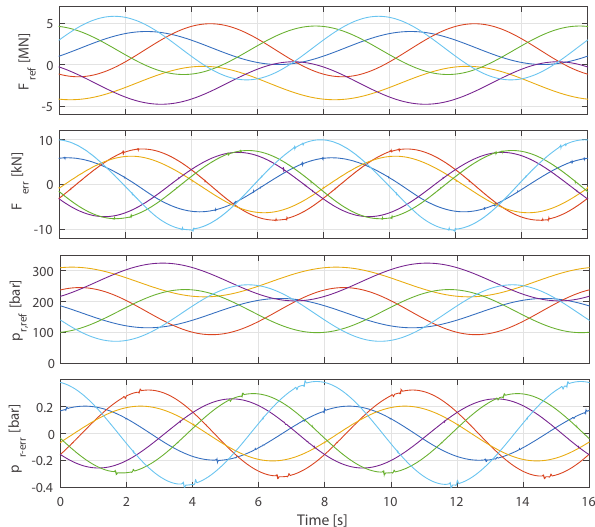
Figure 16: Simulated system response for cylinder force control using three pressure